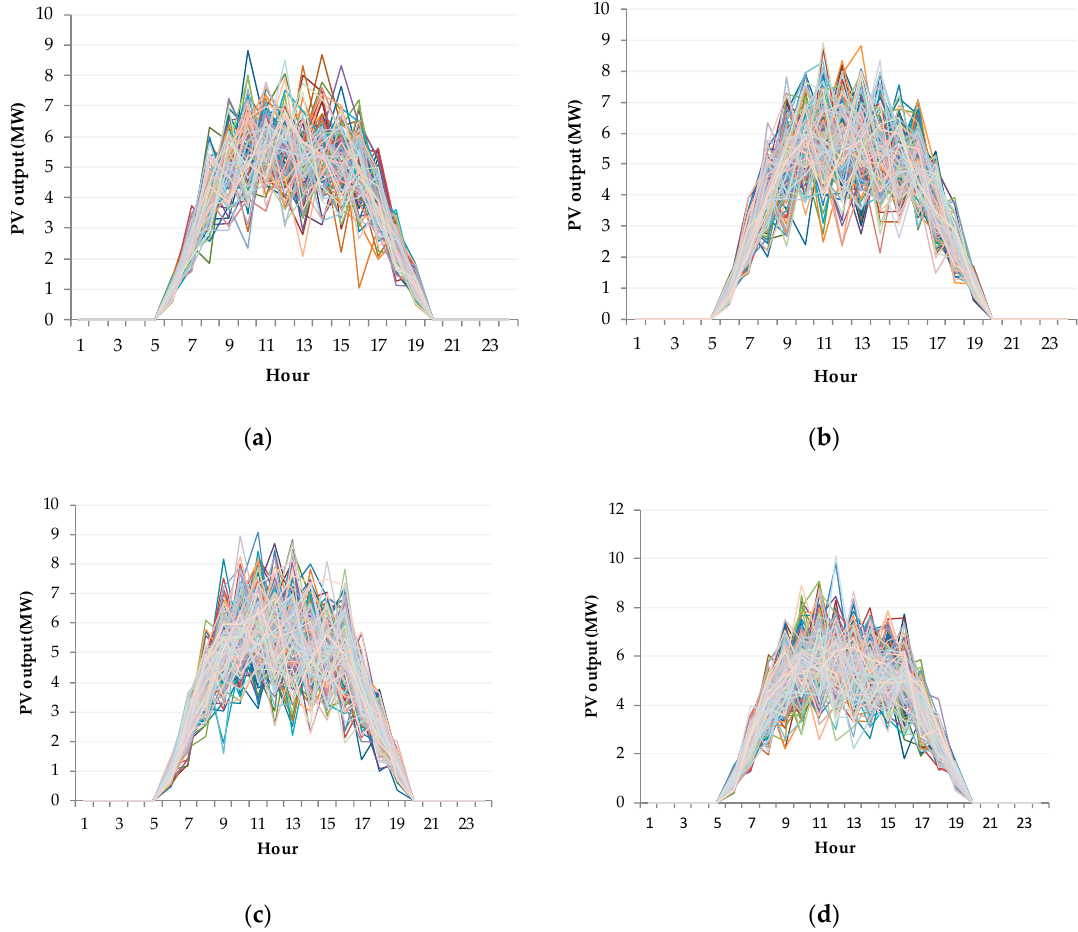
Figure A4. PV power output scenarios of Cases 2–5 randomly generated: ( a ) 100 scenarios (Case 2); ( b ) 150 scenarios (Case 3); ( c ) 200 scenarios (Case 4); ( d ) 250 scenarios (Case 5).